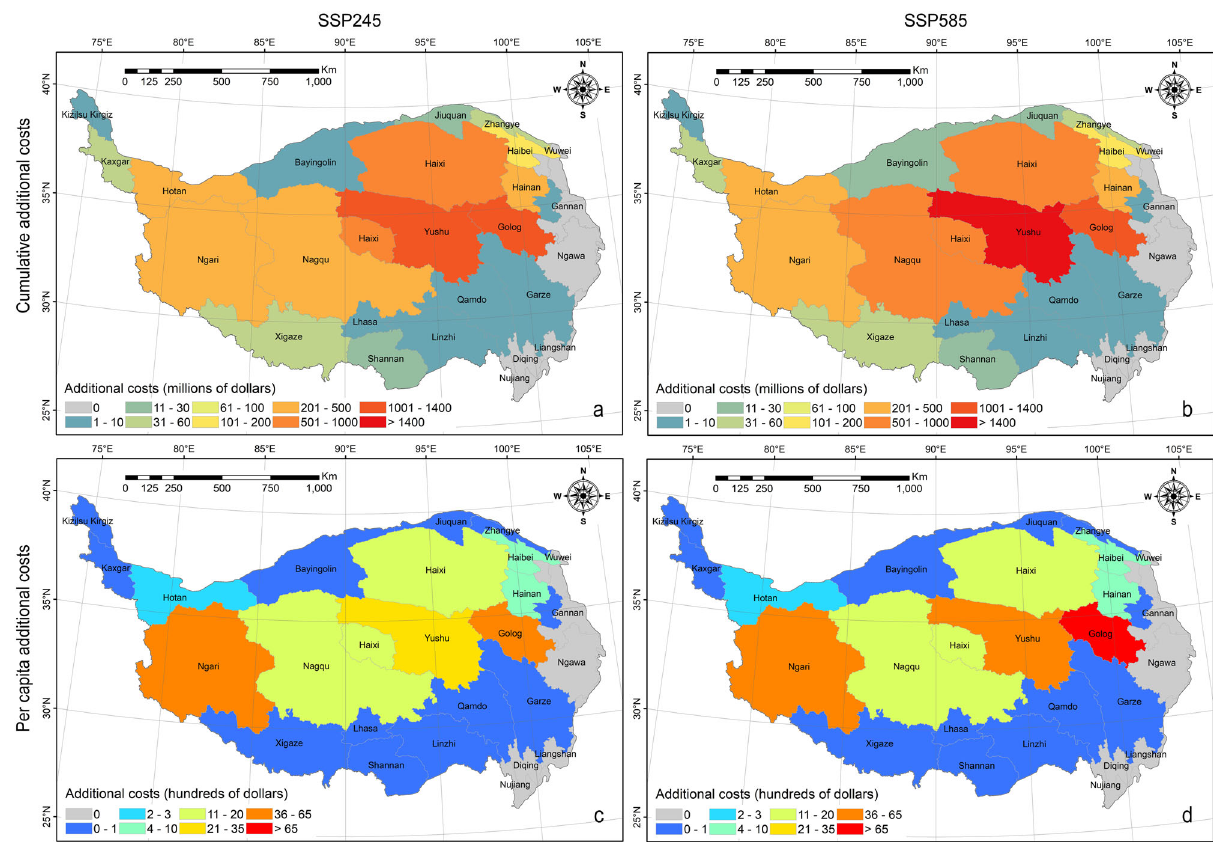
Fig. 4 Distribution of additional costs of current infrastructure with adaptation from permafrost degradation across the Qinghai-Tibet Plateau. Cumulative additional costs (2008 – 2090; net present value in 2008 US dollars, 2.85% annual discount rate) ( a, b ) and per capita additional costs ( c, d ) estimates for each prefectural-level city under SSP245 ( a, c ) and SSP585 ( b, d ). The population data used to calculate the per capita additional cost came from the sixth national census of China in 2010. Boundary of prefectural-level city dataset is from National catalogue Service for Geographic Information (www.webmap.cn) and licensed under CC BY 1.0